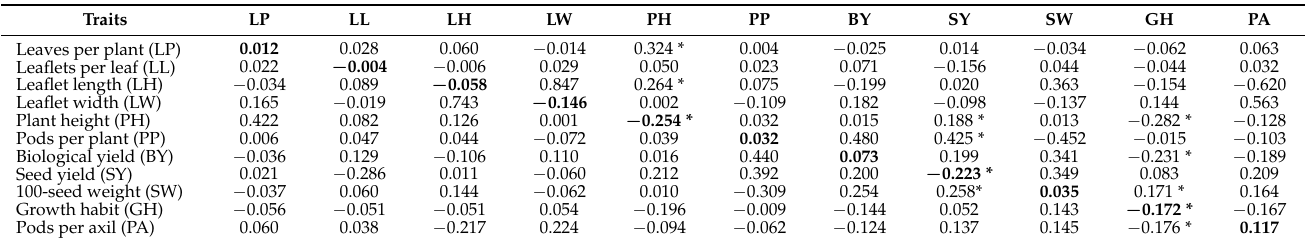
Table 3. Path coefficients on direct (bold) and indirect effects of agro-morphological traits on resistance to the leafminer in RILs derived from interspecific crosses between C. arietinum and C. reticulatum. Traits Leaves per plant